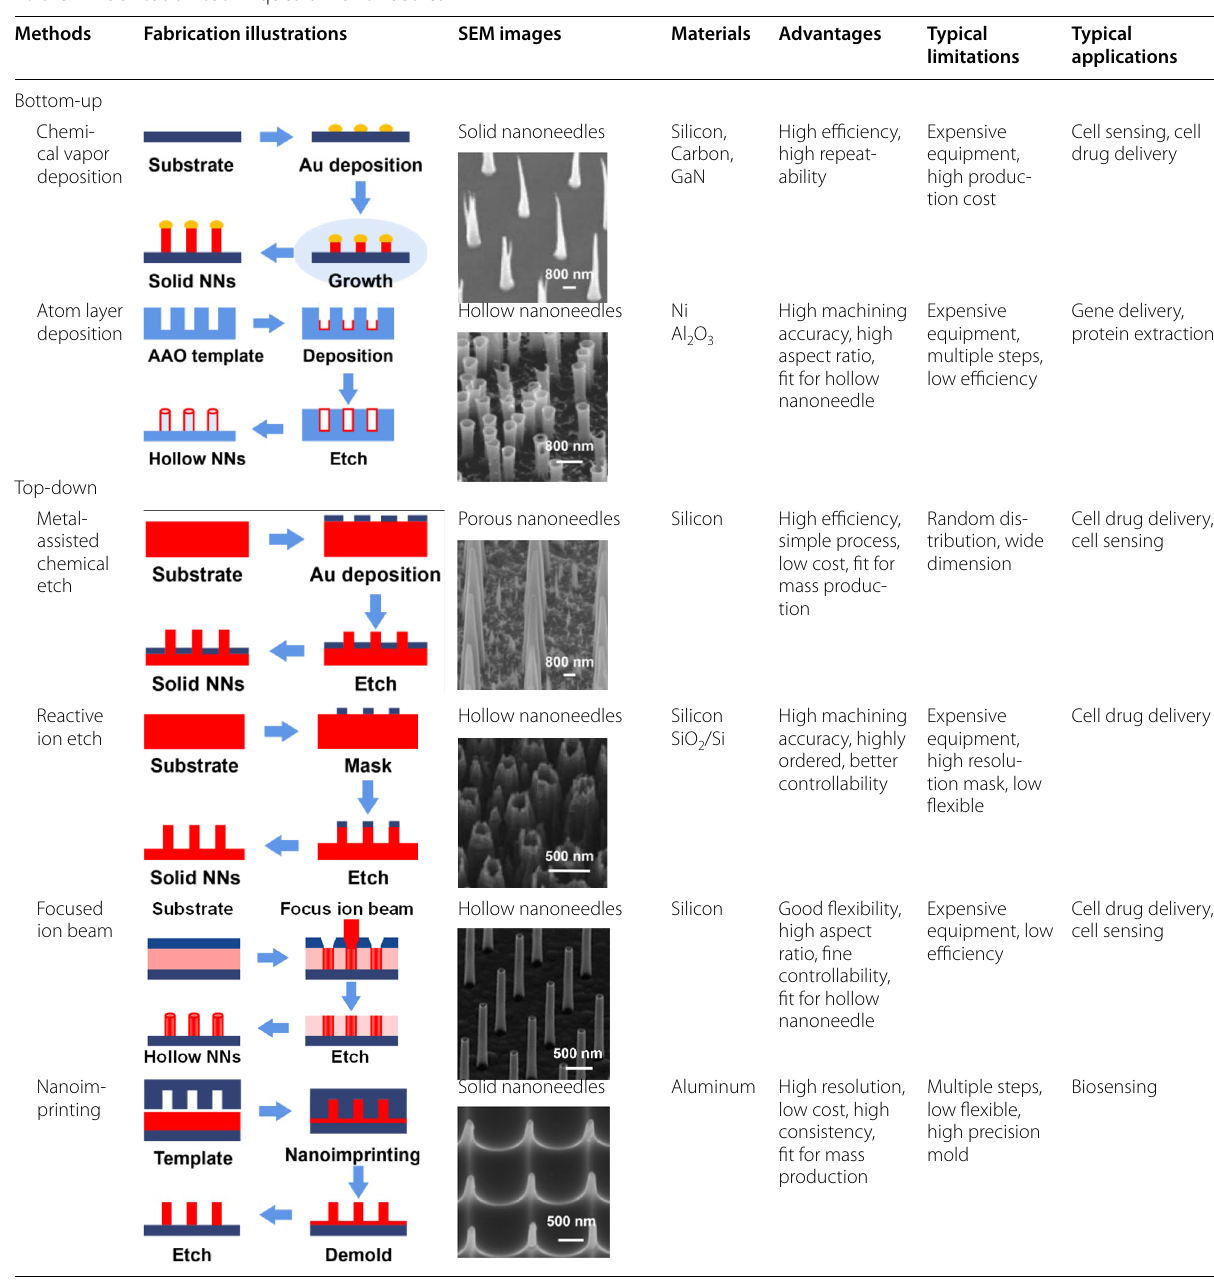
Table 2 Fabrication techniques of